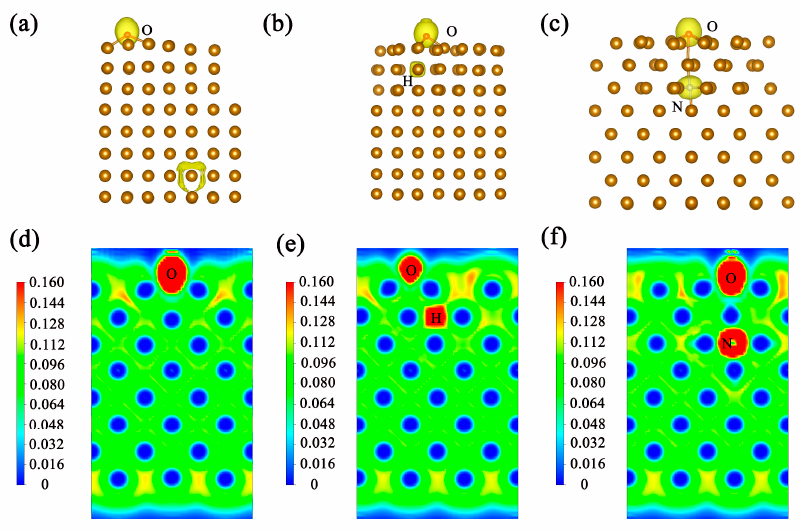
Figure 6. ELF of pure γ -Fe and H/N-containing austenite adsorbed with atomic oxygen. ( a – c ) are the 3D ELF of pure γ -Fe and H/N-containing austenite adsorbed with atomic oxygen, respectively. ( d – f ) are the 2D ELF of pure γ -Fe and H/N-containing austenite adsorbed with atomic oxygen, respectively.